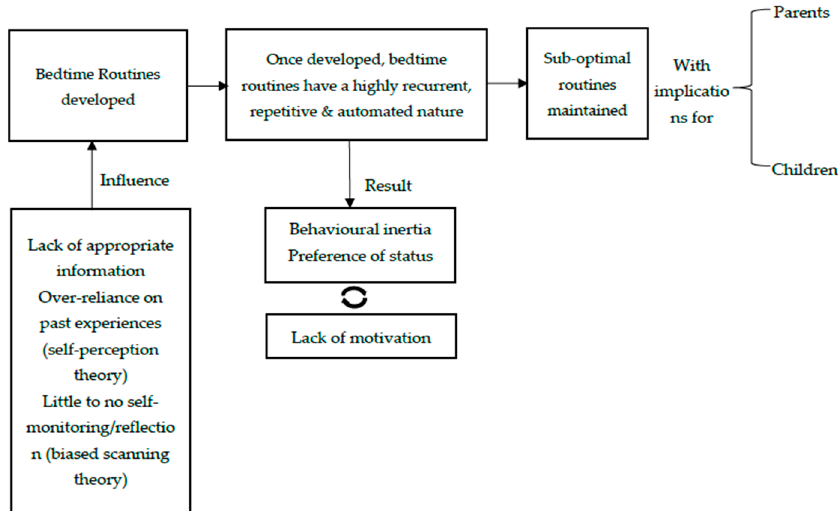
Figure 2. A proposed mechanism for the initial creation and later maintenance of sub-optimal bedtime routines based on TDF results on ‘barriers and facilitators’ (Table 2). Sleep is a vital part of health and wellbeing with multiple and wide ranging implications for child development and wellbeing [2]. Sleep plays a major role for children’s development with poor sleep hygiene and sleeping habits associated with a series of problematic outcomes across physical health [27], neu- rocognitive development [28] , socio-emotional development [29] and family functioning [30]. The importance of bedtime routines for sleep has been recently highlighted by a recommendation by the American Academy of Pediatrics (AAP) which issued a series of sleep health recommendation including the need of a consistent bedtime routine and childhood routines in general [2]. Apart from quality of sleep, sub-optimal bedtime routines could affect a series of other areas in- cluding dental health [6], school readiness and school performance [5,8] and BMI [9].